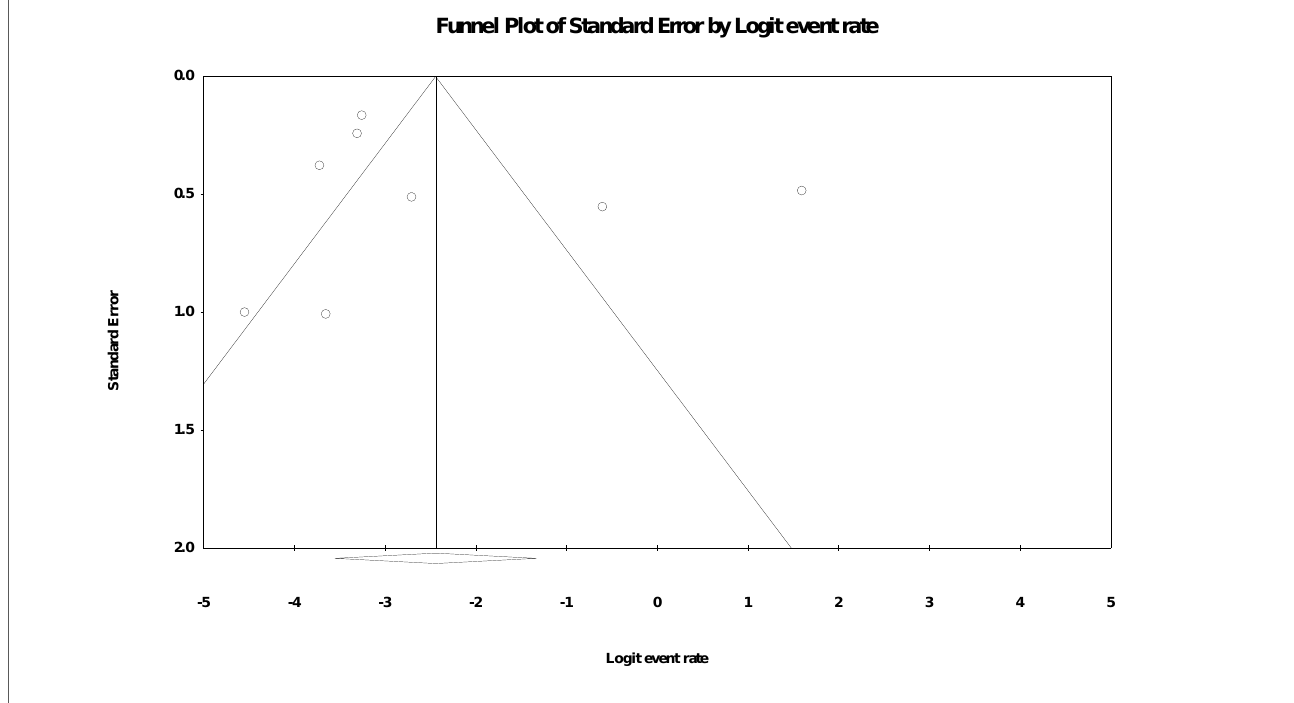
Figure 8. Funnel plot showing publication bias in studies reporting the prevalence of gyrB gene in antimicrobial resistant S. Typhi.